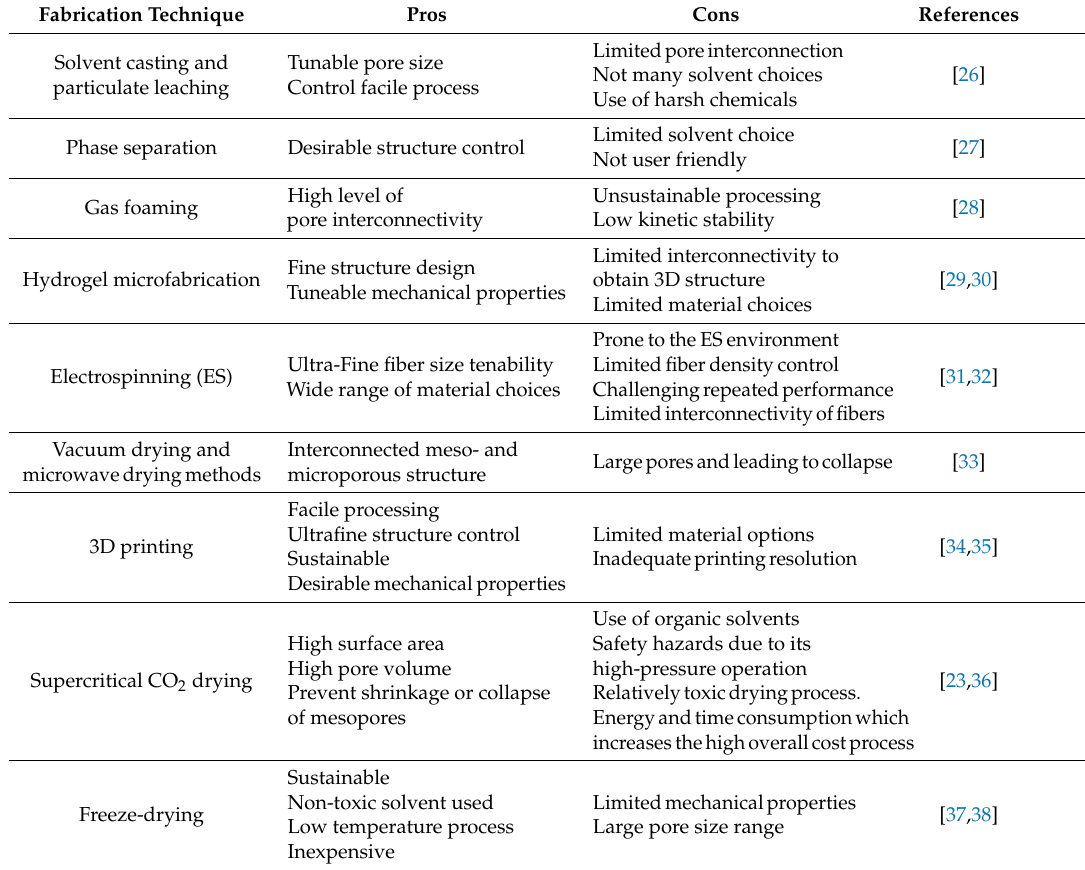
Table 2. Pros and cons of 3D sca ff olds fabrication by various